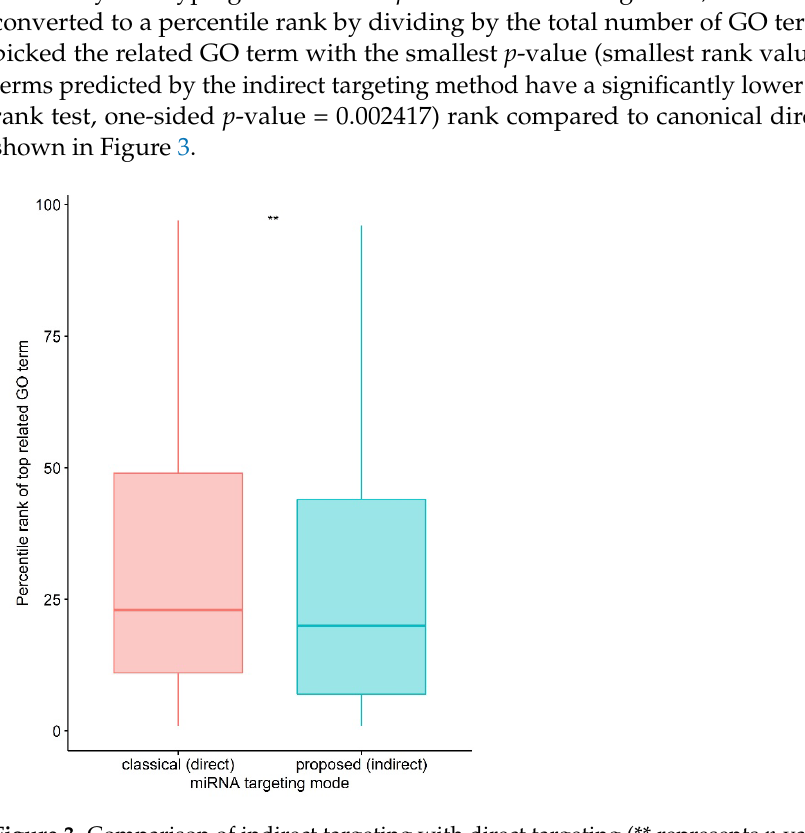
Figure 3. Comparison of indirect targeting with direct targeting (** represents p -value < 0.01)